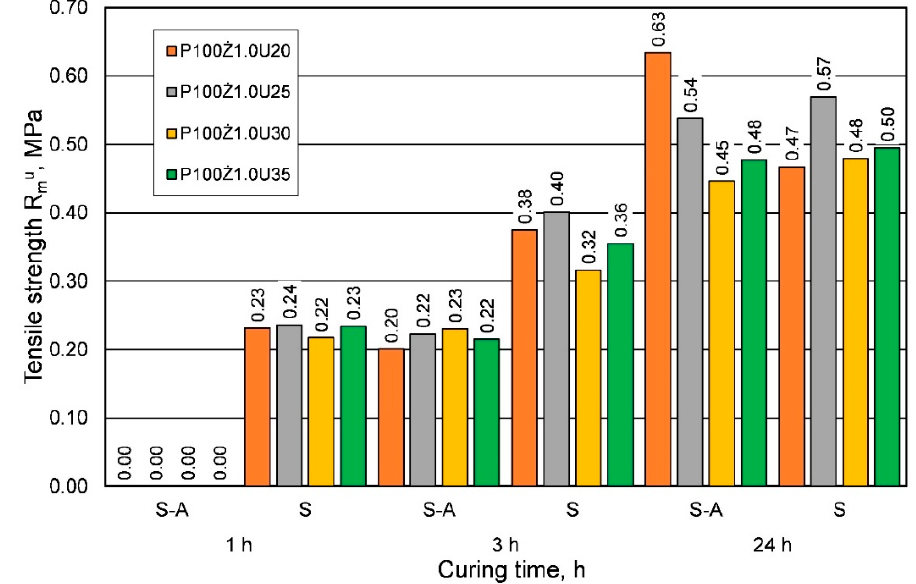
Figure 9. Tensile strength R u m of molding sand based on fresh chromite sand, depending on weather conditions, for different amounts of hardener added.